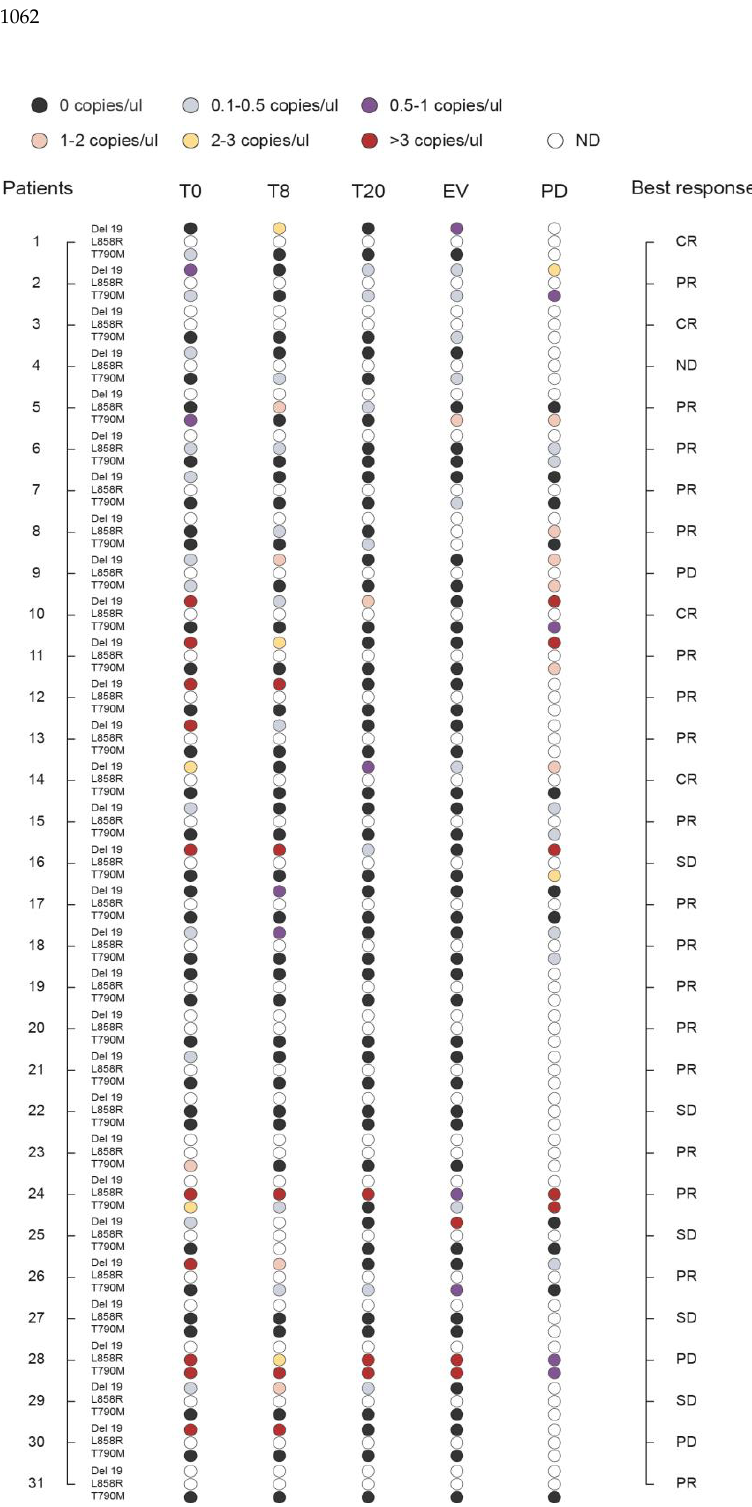
Figure 4. Monitoring the levels of Del 19, L858R, and T790M during therapy. Plasma levels of EGFR mutations (Del 19, L858R, and T790M) in the course of tyrosine kinase inhibitor (TKI) treatment were monitored by analyzing cell-free tumor DNA (cftDNA) by QuantStudio 3D Digital PCR System-Thermo Fisher Scientific at baseline (T0) and serially at 8 days (T8) and 20 days (T20) post-treatment, at the first clinical evaluation (EV), and at disease progression (PD). Quantitative measures are represented as thresholds of numbers of EGFR mutated copies / ul as reported in Table S1 ( n = 31; ND, not determined). Results are presented along with the best clinical response (CR, Complete Response; PR, Partial Response; SD, Stable Disease; PD, Progressive